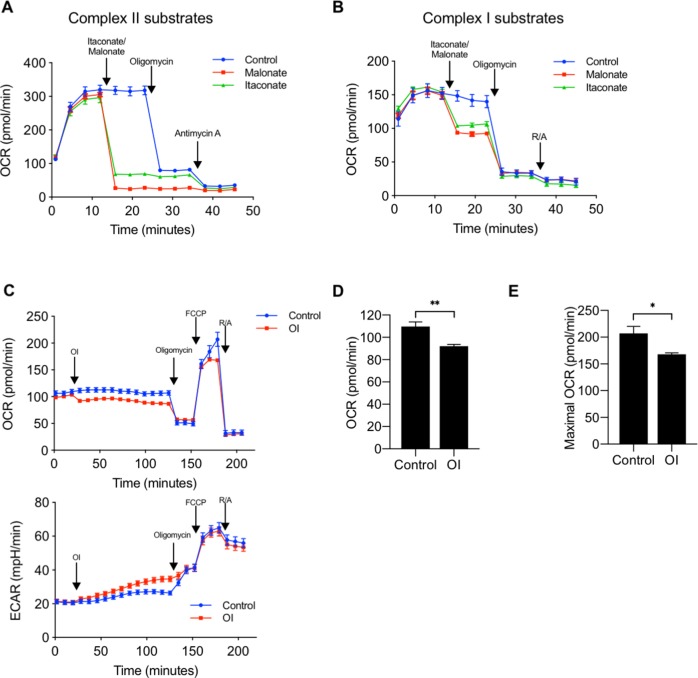
Itaconate decreases oxygen consumption rate via inhibition of complex II, succinate dehydrogenase (SDH).(A) We measured oxygen consumption rate (OCR) in permeabilized BMDMs (using XF plasma membrane permeabilizer) in the presence of ETC complex II substrate (succinate, 10 mM) and complex I inhibitor (rotenone, 2 mM), followed by injections of 1) media (control, n = 6), itaconate (10 mM, n = 6) or malonate (10 mM, n = 6), a known complex II inhibitor, 2) oligomycin (2 mM), an ATP synthase inhibitor, and 3) Antimycin A (2 mM), a complex III inhibitor. Both itaconate and malonate significantly decreased OCR. (B) We measured OCR in permeabilized BMDMs in the presence of ETC complex I substrates (pyruvate, 10 mM and malate, 0.5 mM) followed by injections of 1) itaconate or malonate, 2) oligomycin, or 3) rotenone and antimycin A (R/A) (n = 6). (C) We performed a mitochondrial stress test to measure OCR and ECAR in BMDMs treated with 4-octyl itaconate (OI) (0.25 mM) or vehicle control (n = 8). OI acutely decreased both (D) basal OCR and (E) maximal OCR measured at third time point after FCCP. Significance was determined using two-tailed unpaired student’s t-test, *p<0.05, **p<0.01, ***p<0.001.